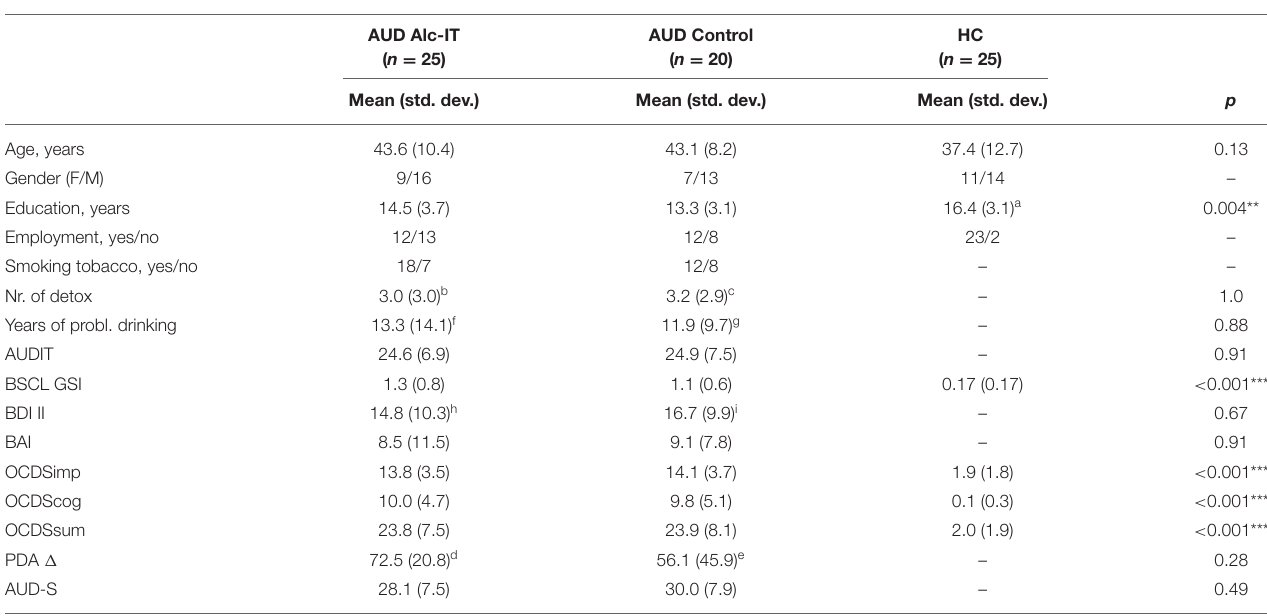
TABLE 1 | Descriptive statistics and clinical scores stratified by study